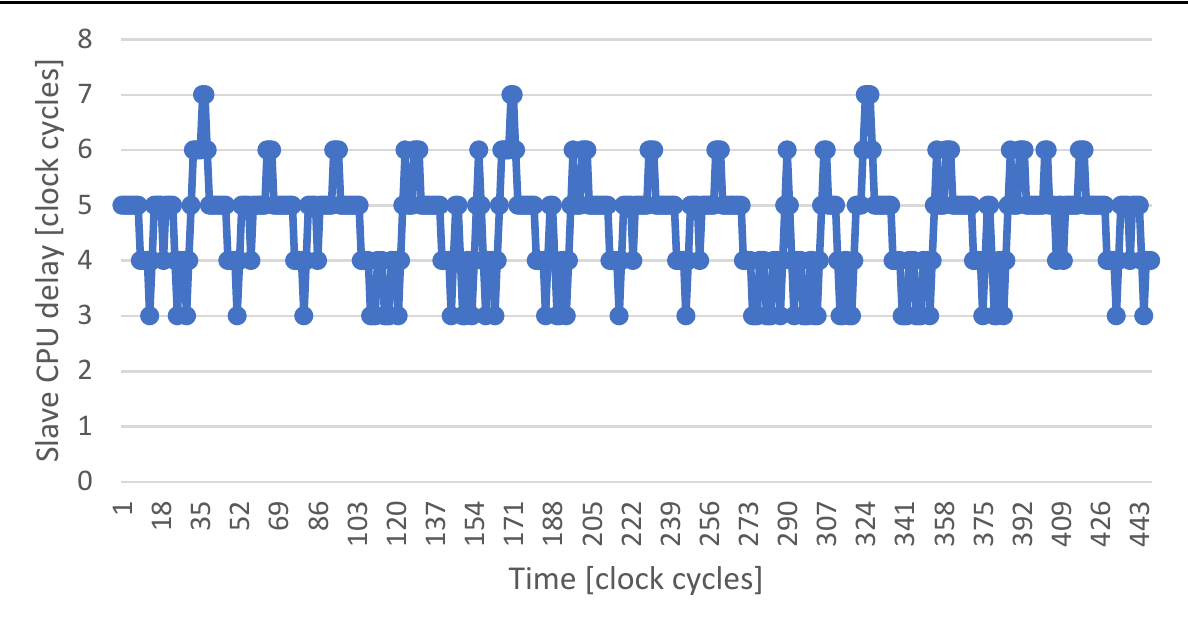
Figure 9. Trace of the delay between the master and slave cores in VDCLS execution.